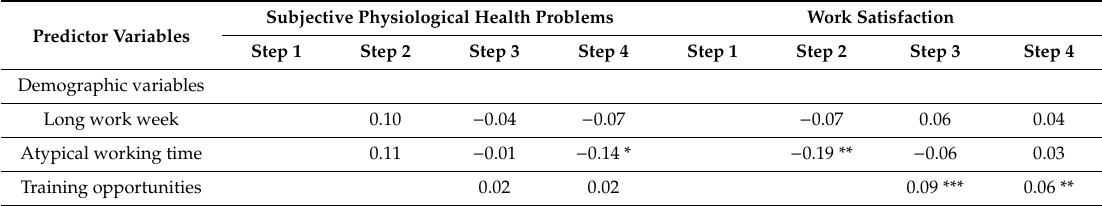
Table 8. Hierarchical regression analyses with subjective physiological health problems and work satisfaction as outcome